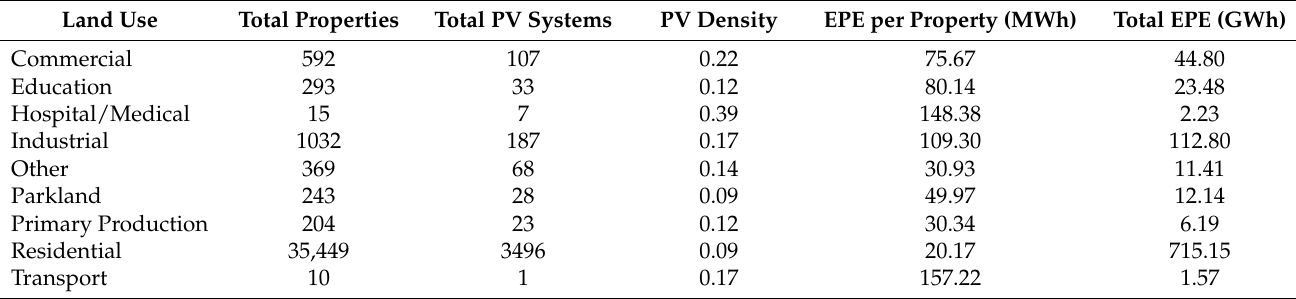
Table 5. Detected solar panels and EPE values in each land use.